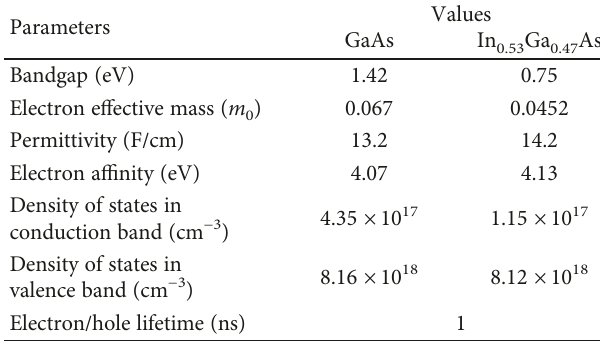
Table 1: Values of di ff erent parameters